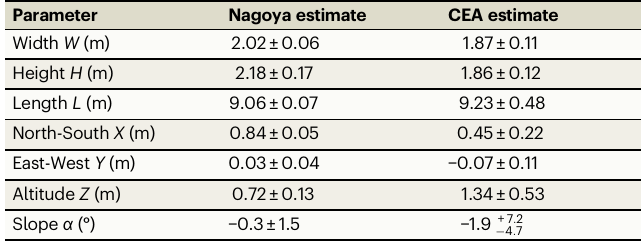
Table 1 | Summary of the NFC